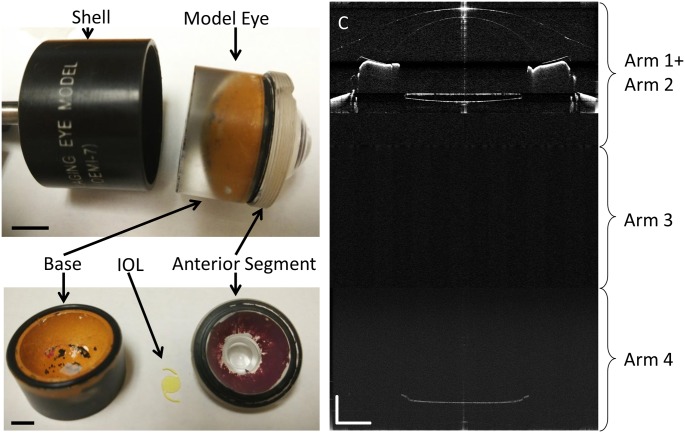
A model eye with an IOL used for calibration.A model eye (upper left) was used to calibrate the measurement. Bar = 1000μm. The crystalline lens in the model eye was replaced with an IOL (lower left). Bar = 500μm. The full eye image (right) obtained with the long scan depth OCT clearly shows the IOL and other structures of the model eye, yielding the OCT axial biometry. Bar = 2000μm.